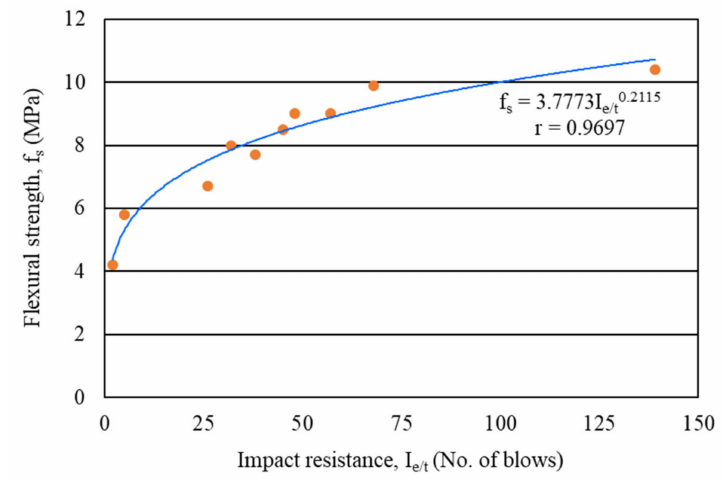
Figure 14. Correlation between the flexural strength and impact resistance of mortar composites.